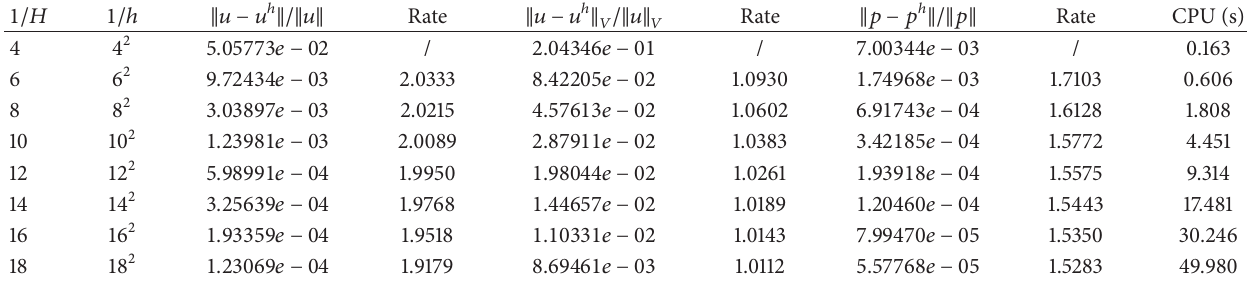
Table 3: Convergence of two-level Stokes iteration method.